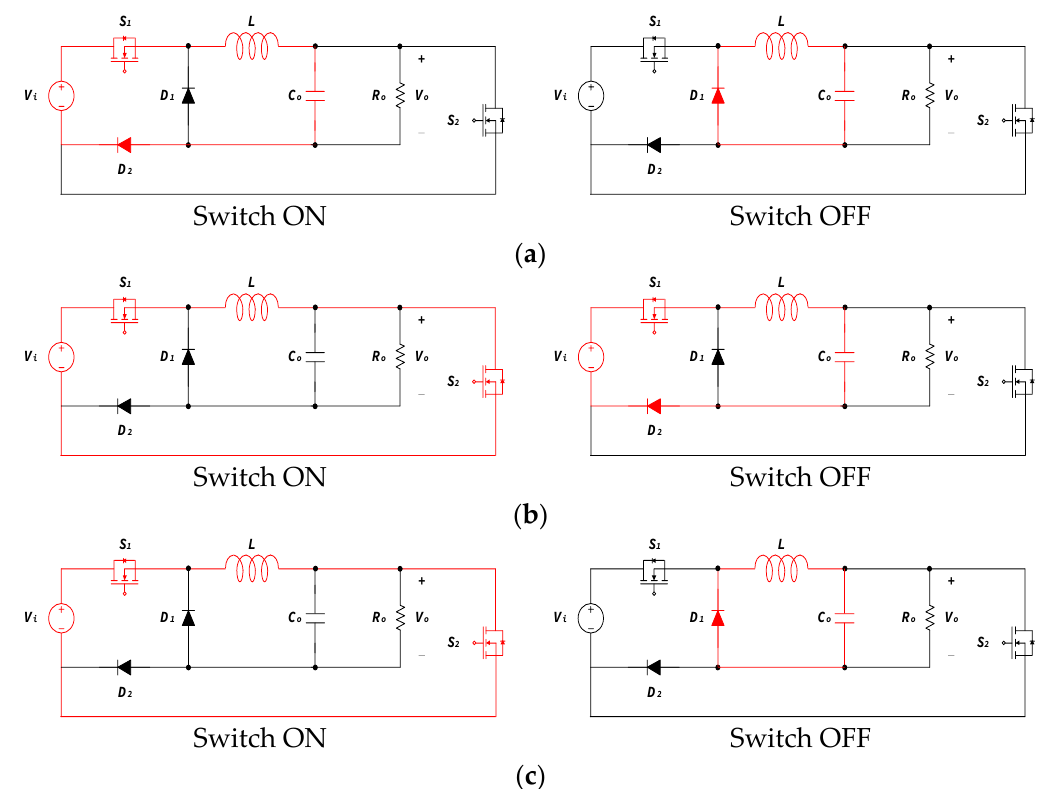
Figure 4. Operation principle of the proposed TSBB converter: ( a ) Buck; ( b ) Boost; ( c ) Buck-boost. Table 5. Switching and conduction semiconductors of the conventional and proposed TSBB converters: (a) Switching semiconductors; (b) Conduction semiconductors. Ref. [5] Topology